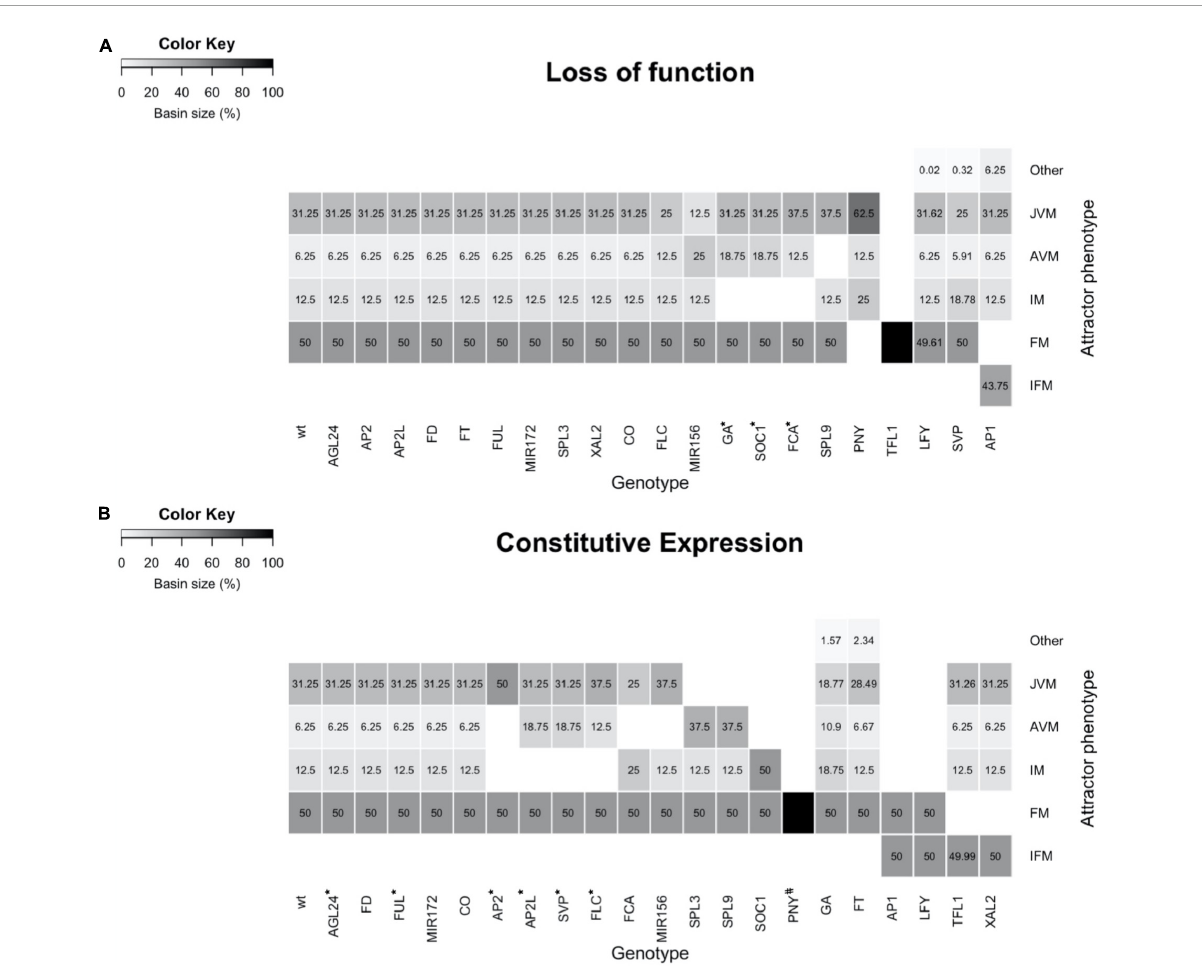
FIGURE6 The mutant’s simulations with the FT-GRN Boolean model yield attractors like the observed mutant’s phenotypes. (A) Simulation of single loss of function, or (B) constitutive expression mutants. The basin size of each meristem state (phenotype) in relation to all state space was plotted as a heatmap. Different types of meristems were specified as JVM, AVM, IM, FM, a chimeric inflorescence-floral meristem (IFM), and other chimeric cyclic attractors (Other). Most simulations recovered the phenotypes described in the literature. However, some mutants’ phenotypes were partially recovered (*), and some mutants have not been described yet